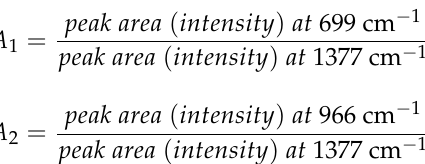
Figure 4. Infrared spectrum of SBS, base asphalt, rubber oil and SBS modified asphalt.